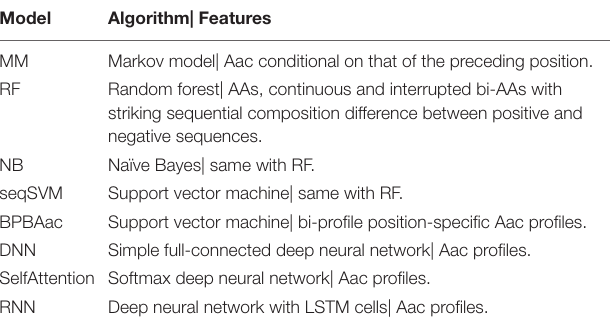
TABLE 1 | Models and the optimized parameters. Model Algorithm| Features